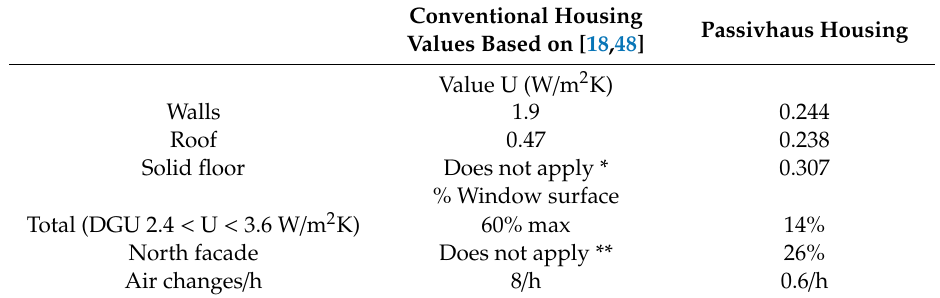
Table 3. Comparison between conventional housing characteristics and the designed